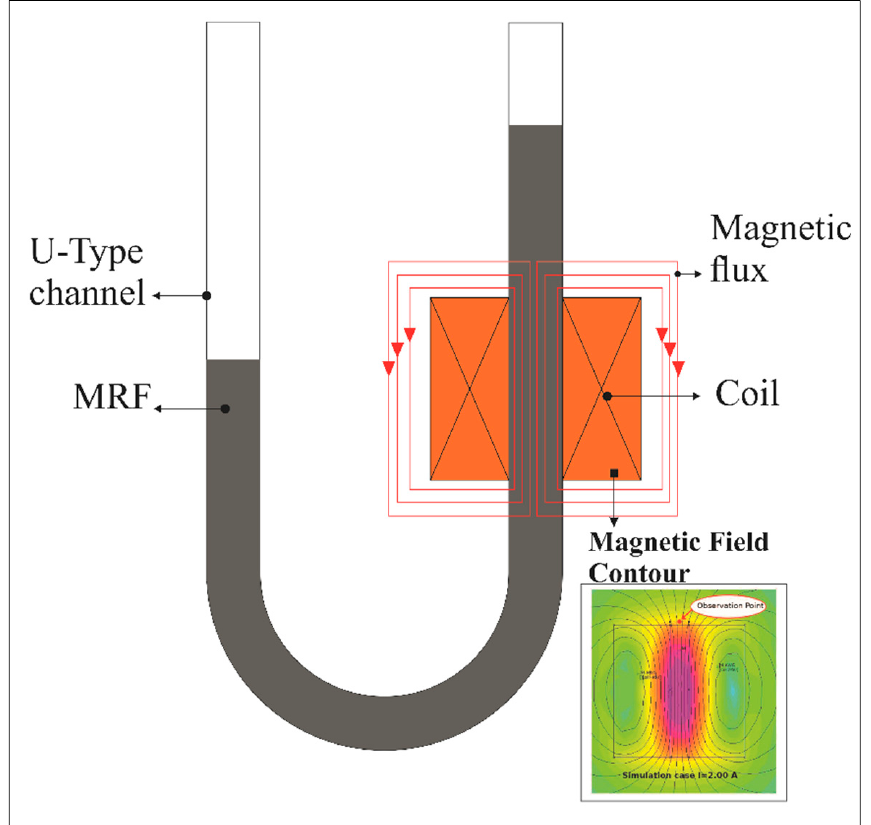
Figure 1. A schematic U-type channel and magnetic coil used for testing.